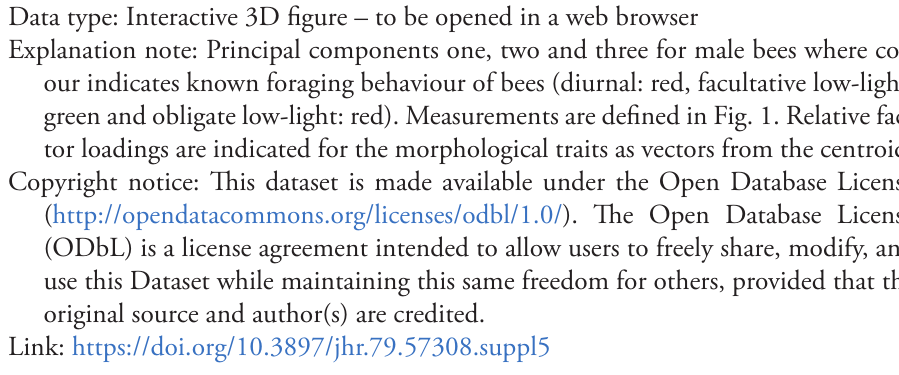
Data type: Interactive 3D figure – to be opened in a web browser Explanation note: Principal components one, two and three for male bees where col- our indicates known foraging behaviour of bees (diurnal: red, facultative low-light: green and obligate low-light: red). Measurements are defined in Fig. 1. Relative fac- tor loadings are indicated for the morphological traits as vectors from the